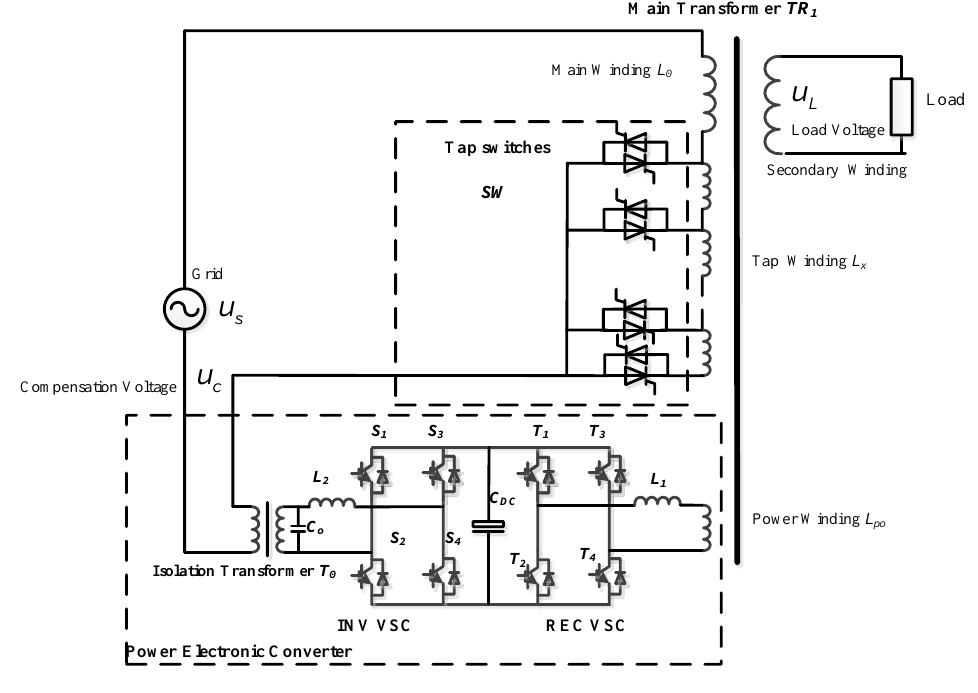
Figure 1. Single-phase topology structure of Flexible OLVR Transformer. The primary side winding can be divided into main winding, tap winding and power winding. The power winding could be defined as a section of tap winding of traditional OLTC transformer or a separate isolating winding. The tap switches SW are set at the primary side of the main transformer, and the switches SW is connected to the tap windings Lx of the main transformer. By controlling the switches SW , the winding regulation of the primary side can be realized, so as to control the ratio of the main